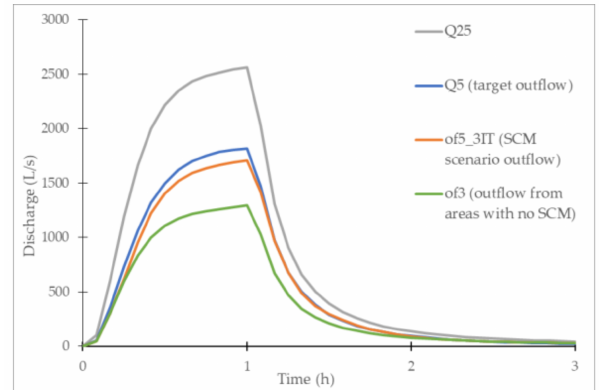
Figure 6. The results of the 3IT scenario, which includes three types of an infiltration trench, for DE_Q5_P25.